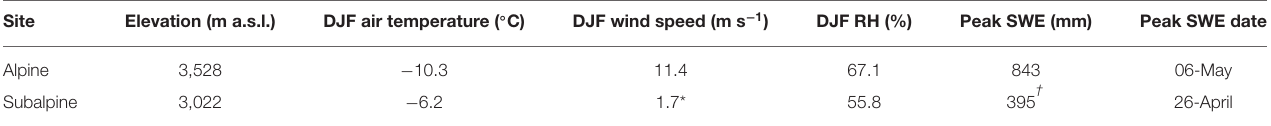
TABLE 1 | Mean meteorological quantities for December, January, and February (DJF) at the alpine and subalpine sites (WY1991–WY2013) along with mean peak SWE magnitude and timing for the two sites as observed in the snow pits (WY2007–WY2013). Site Elevation (m a.s.l.) Peak SWE date Alpine Subalpine